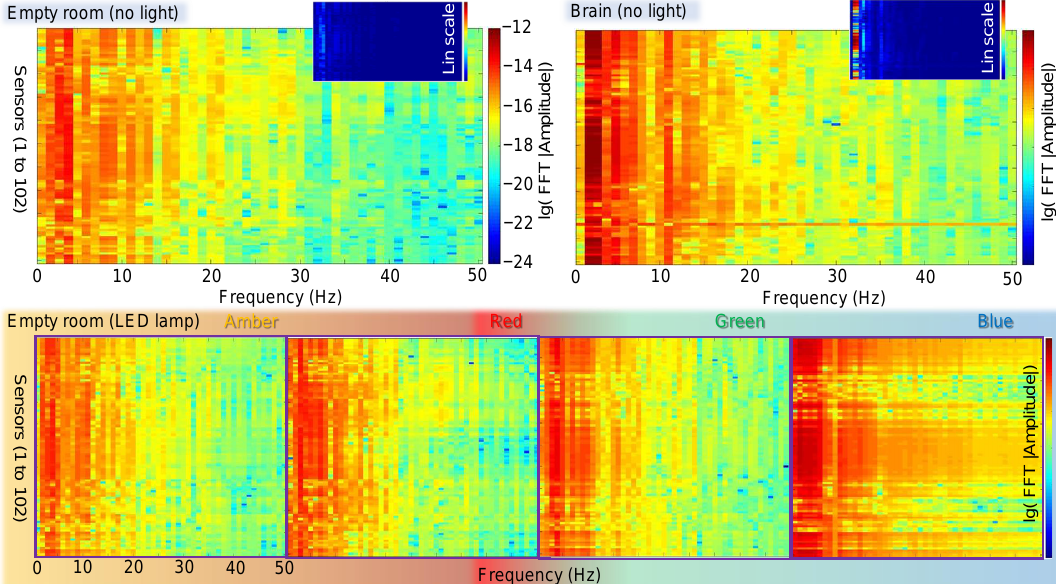
Figure 5. Magneto-encephalography (MEG) sensor frequency response. The top row shows Figure 3. The top row measurement is an absolute value of fast Fourier transform (FFT) filtered data at 1 Hz sampling step; insets show the same plots in linear intensity scale. The bottom row is a MEG setup response to the RGB+amber illumination (Figure 4) without a person in the MEG seat. Note that the MEG room’s shielding was effective by design against 50 Hz power supply